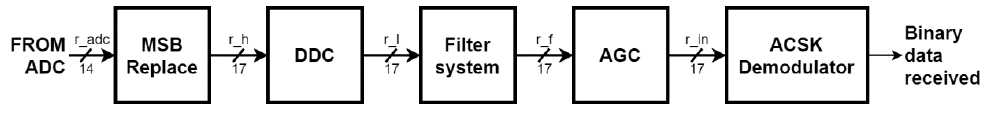
Figure 12. The general structure of the